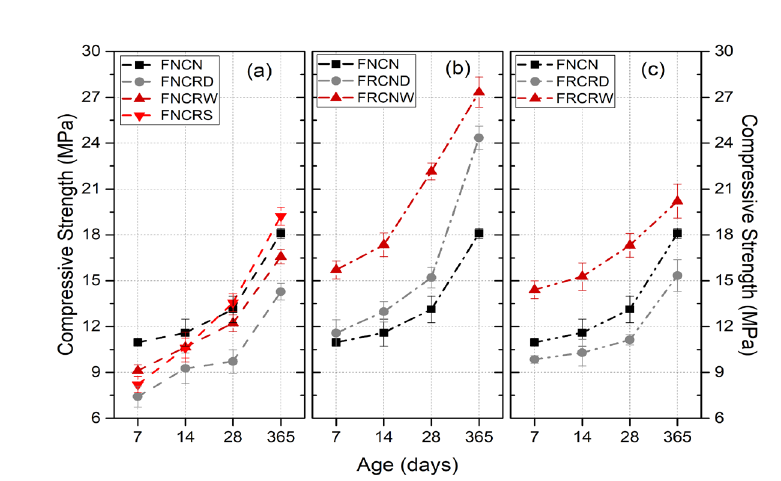
Figure 8. Compressive strength of the blocks tested by fine and coarse